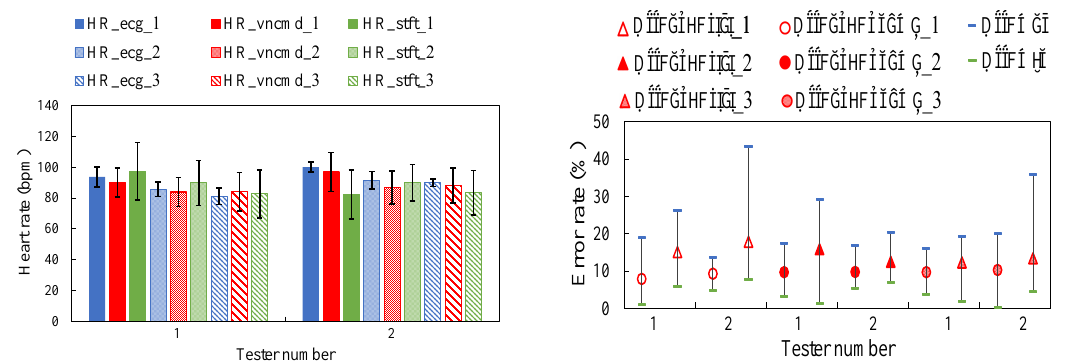
( b ) Error rates of static targets in 1 m. Figure 9. Results on static testers in spot 1.